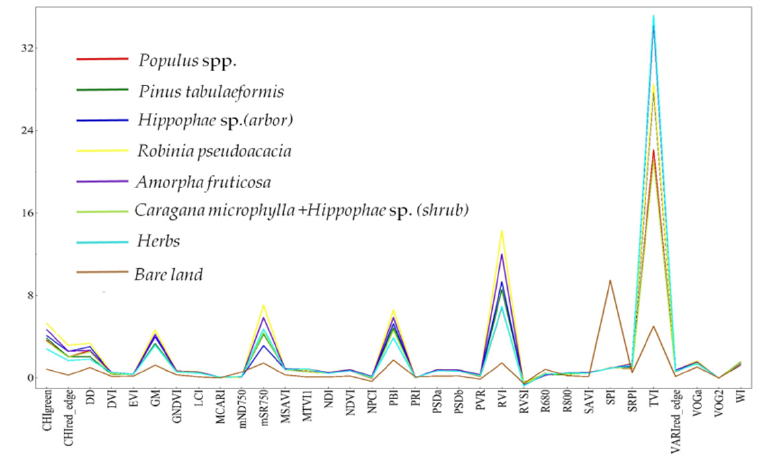
Figure 8. Vegetation indices of eight types of vegetation species composition.